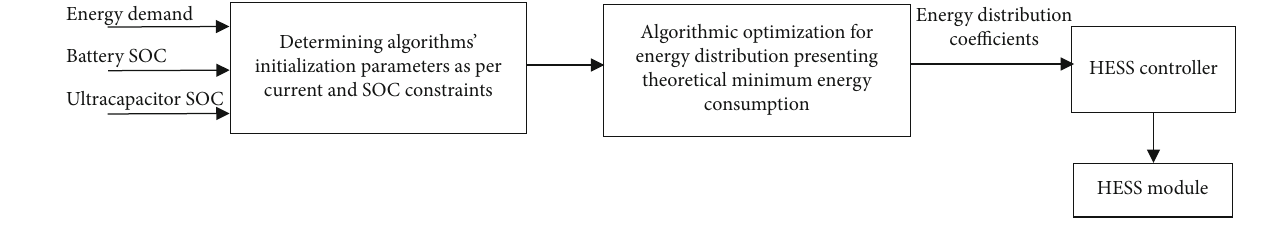
Figure 4: HESS control strategy block diagram.